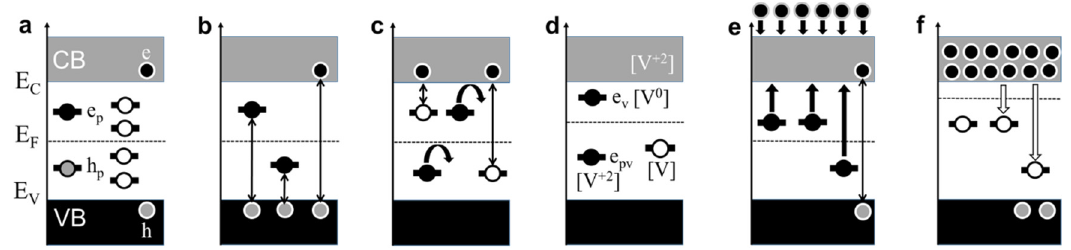
Figure 4. Electronic processes. Schematics of ( a ) electronic band structure, ( b ) excitations from the valence band, ( c ) excitations from in-gap states, ( d ) oxygen-vacancy related in-gap states, ( e ) excitations and injection under applied voltage, ( f ) relaxation to in-gap states.